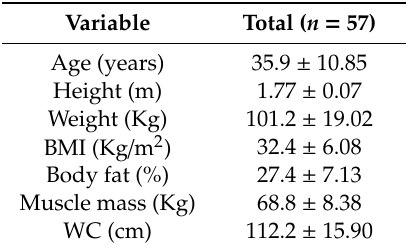
Table 2. Anthropometric characteristics of the study